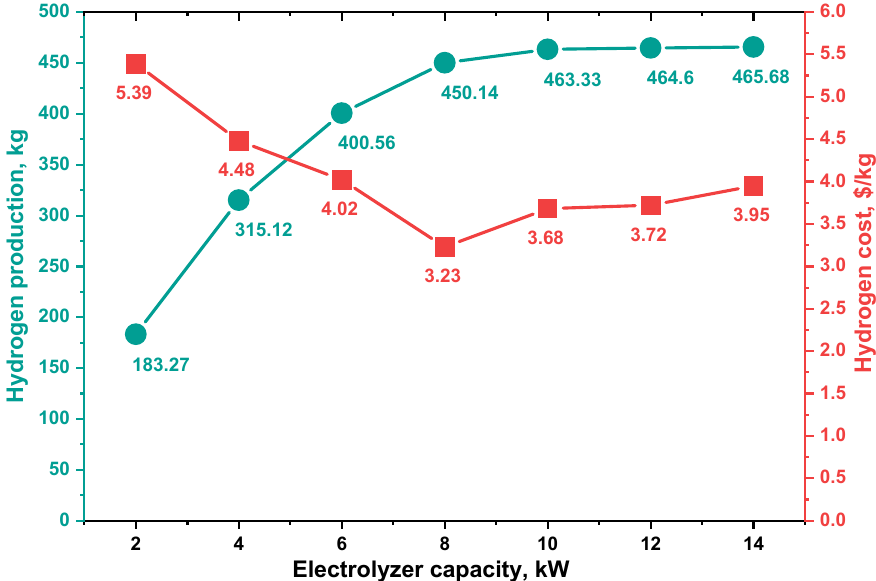
Figure 10. Annual hydrogen production by an electrolyzer and hydrogen costs at several capaci- ties.